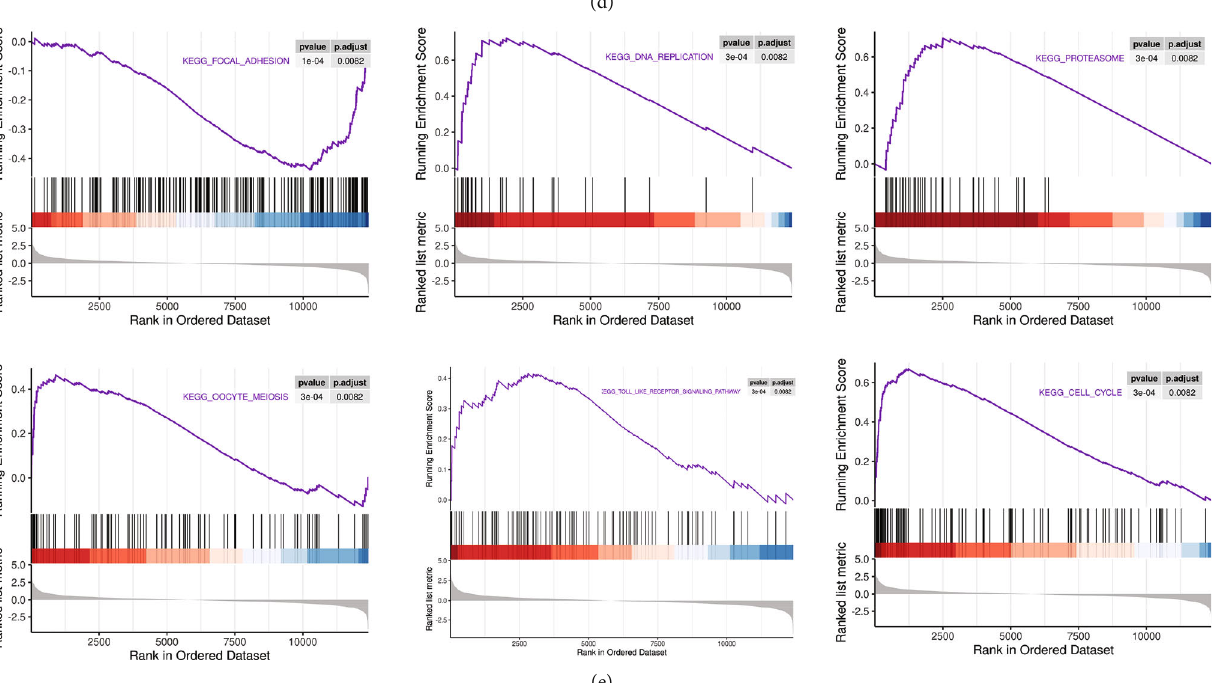
Figure 1: Common DEGs screening, expression changes, and functional and pathway enrichment analysis. (a) Intersection of GSE29929 and ferroptosis; (b) heat map of expression of common DEGs; (c) results of GO functional analysis of common DEGs; (d) results of KEGG pathway enrichment of common DEGs; (e) results of GSEA analysis of common